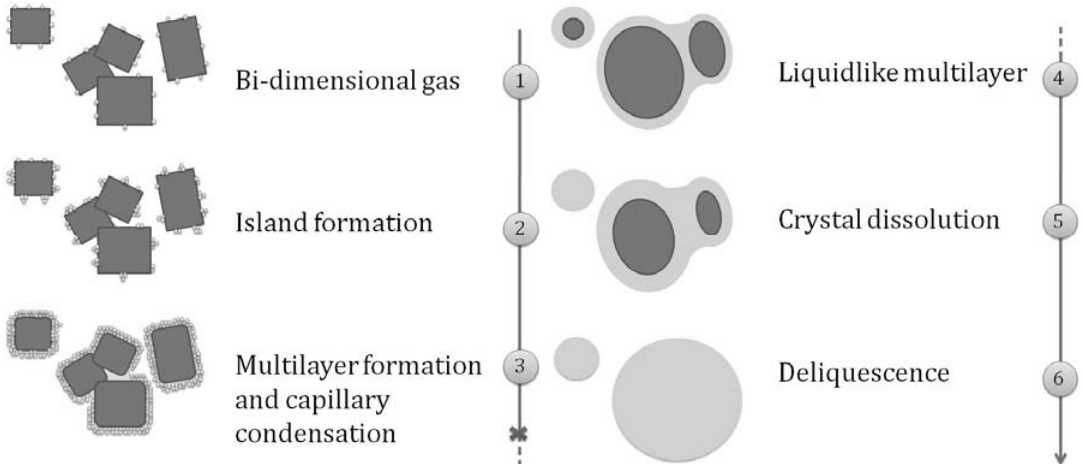
Fig. 1 Hygroscopic crystals in water vapors: adsorption of water vapor and condensation of liquid water followed by dis- solution of a solid (adapted from Peters 4) , Zasetsky 5) and Mauer 2)